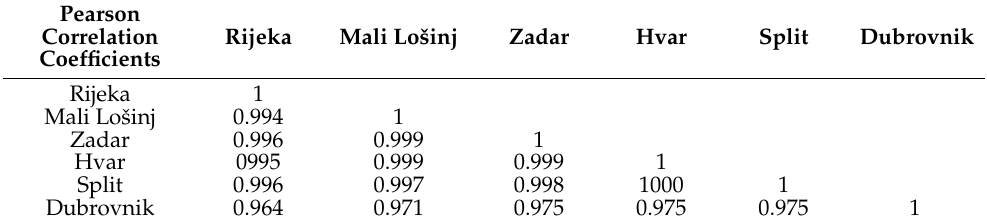
Table 7. Correlation coefficients of the number of Sun’s hours between locations in the Adriatic Sea. Pearson